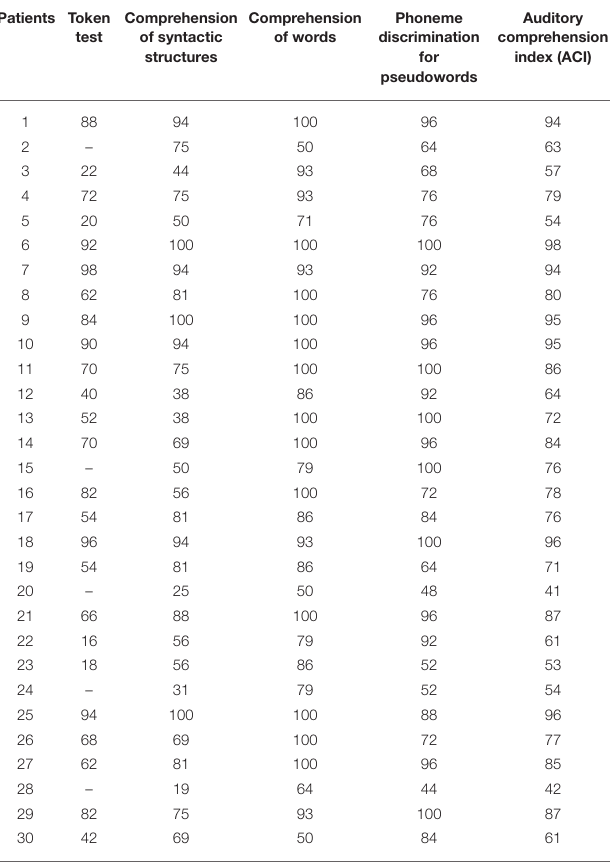
TABLE 2 | Performance on particular language tests (percent of correct responses). Comprehension Patients Token Comprehension of test of syntactic structures